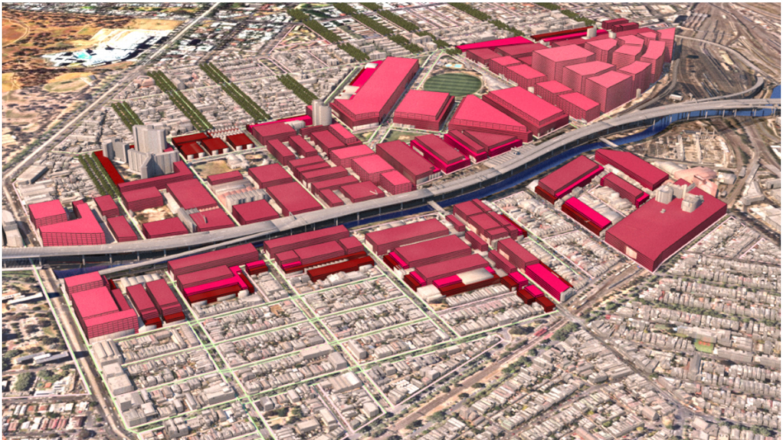
Figure 4. Massing model of maximum building envelopes regulated in the C190 amendment: dark red, 10.5 m interfacing residential areas; pale pink, height restrictions up to 60 m. Image by authors using multi-criteria street design decision support modelling approach in Autodesk™ 3ds